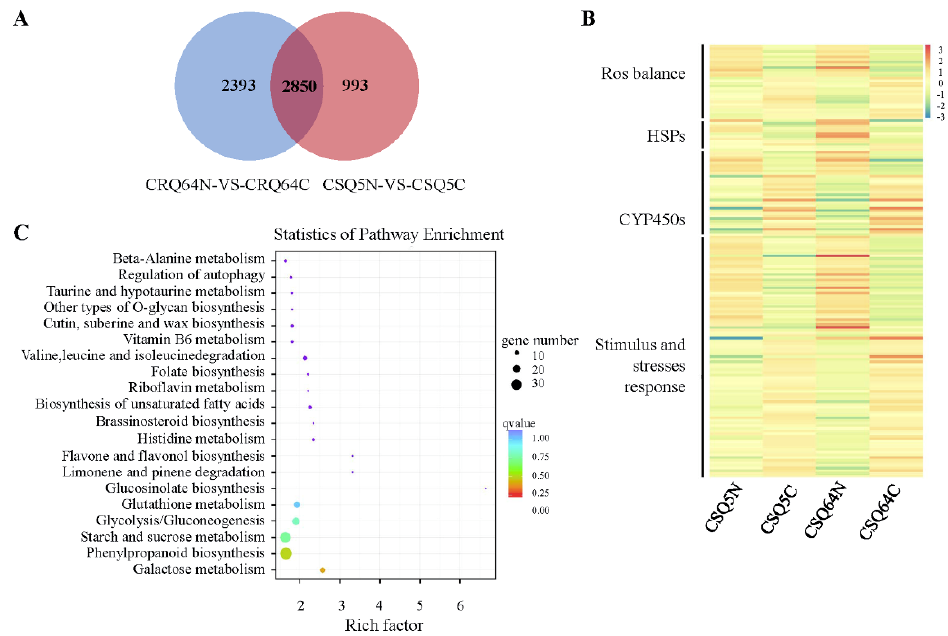
Figure 3. Analysis of DEGs in CSQ5 and CRQ64. ( A ) Venn diagram of DEGs. ( B ) Heatmap depicting expression pattern of genes associated with stimulus and stress response genes, ROS balance, CYP450s, and heat shock proteins (HSPs). The heatmap shows log2(FPKM) values of each protein. ( C ) KEGG enrichment of DEGs found in CRQ64 specifically.